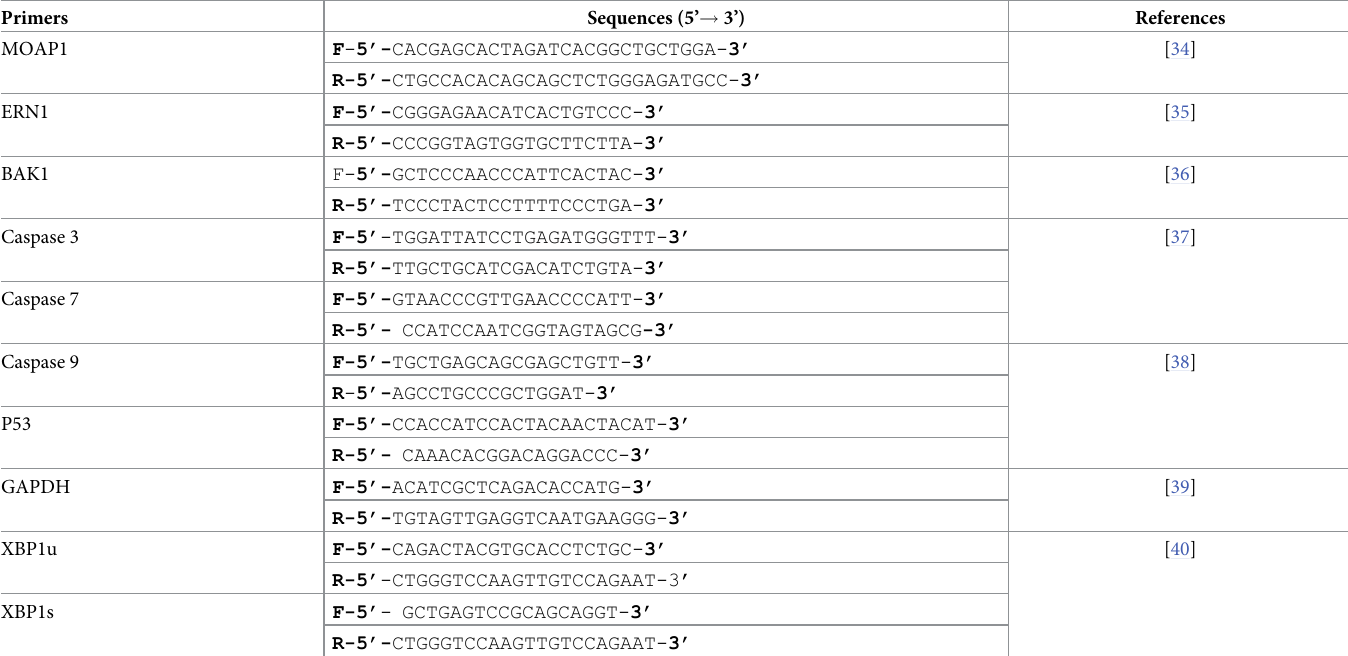
Table 1. List of